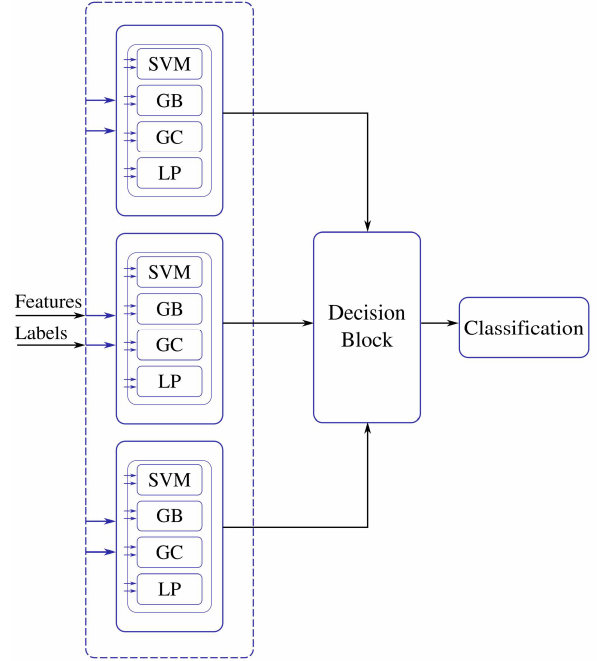
Figure 6. Energy, mean, and variance features are calculated from the Jasper HSI training samples and are input to the ML algorithms. The decision block selects the best machine for each class and uses the selected machines to label the testing samples.